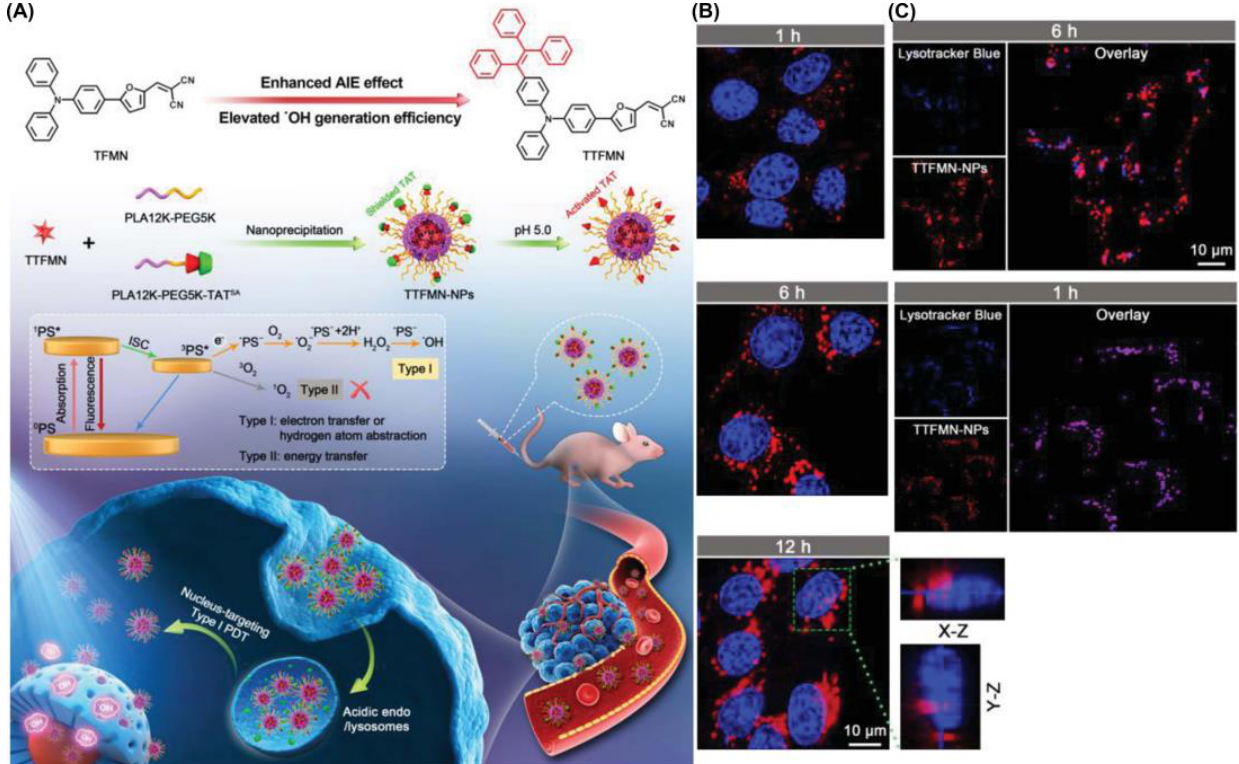
Figure 19. ( A ) Molecular structures and multifunctional phototheranostic application of TTFMN-NPs; ( B ) intracellular tracking on 4T1 cells; ( C ) CLSM images of nuclear targeting delivery on 4T1 cells. Reprinted with permission from Ref. [61]. Copyright 2021 WILEY-VCH.